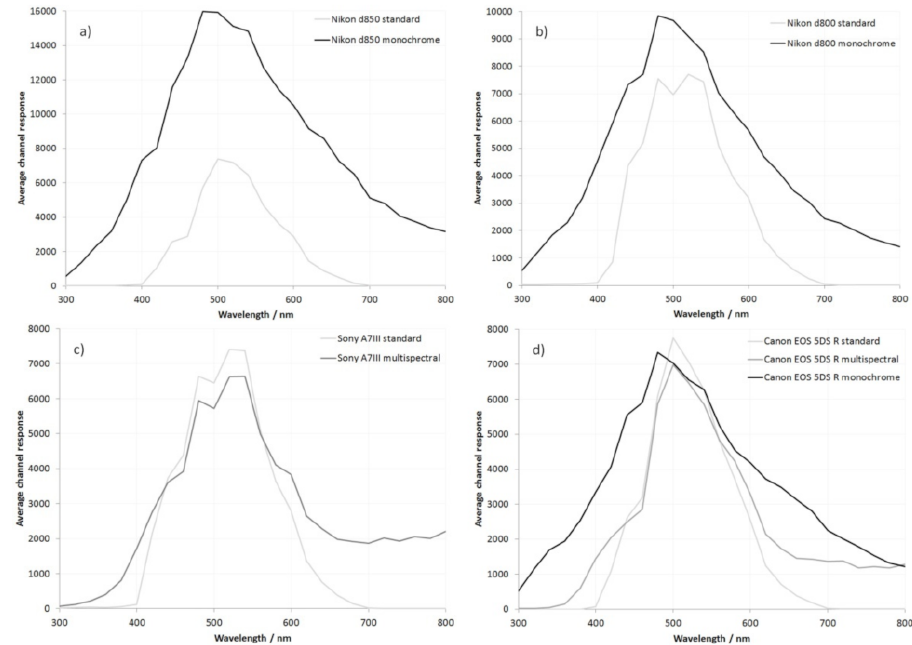
Figure 2. Averaged sensor channel response curves between 300 and 800 nm for ( a ) standard and monochrome Nikon d850; ( b ) standard and monochrome Nikon d800; ( c ) standard and multispectral Sony A7III; and ( d ) standard, monochrome, and multispectral Canon EOS 5DS